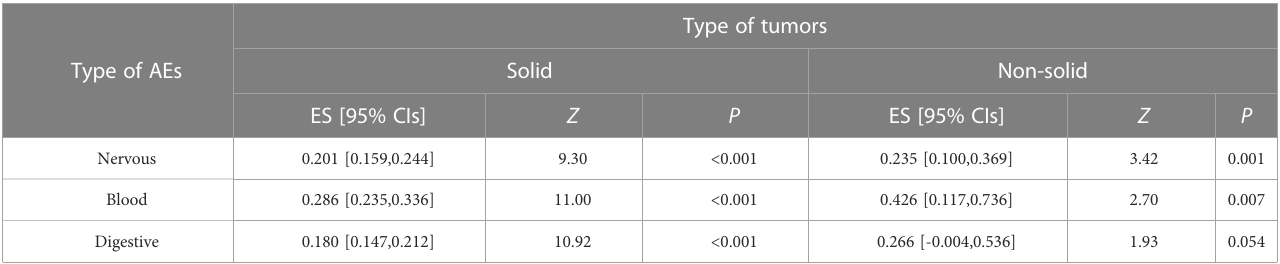
TABLE 5 The incidence of AEs in the overall estimate with different tumor types.